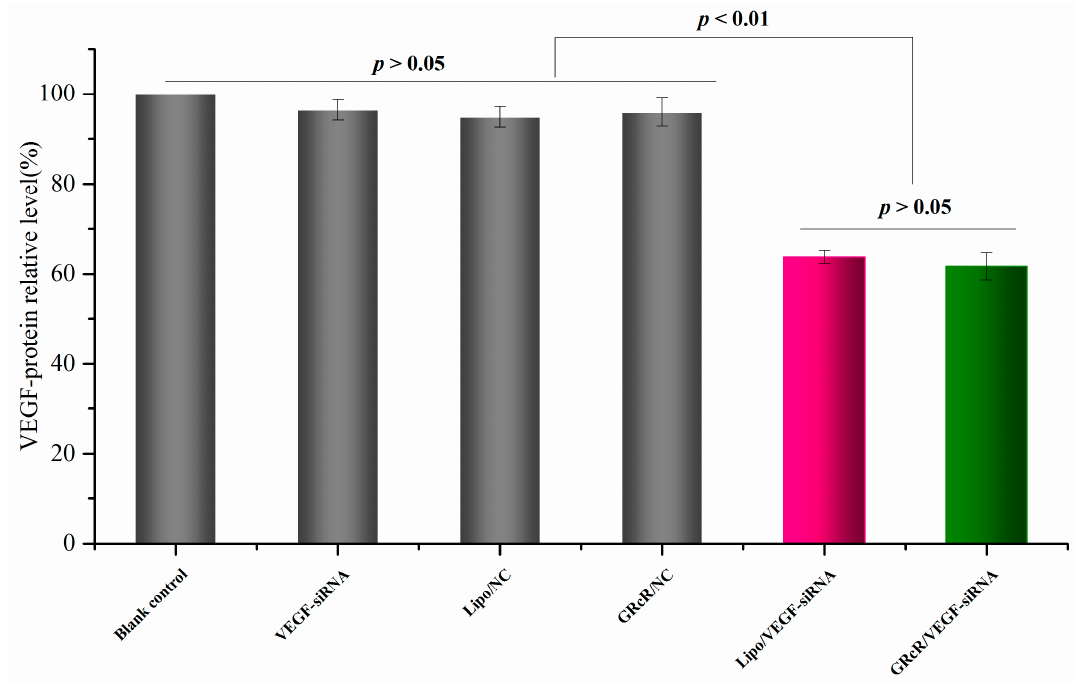
Figure 14. VEGF protein level of HeLa cells, treated with VEGF-siRNA , Lipo™2000/NC, GRcR/NC, and GRcR/ VEGF-siRNA . The data was presented as the mean ± SD, n = 3.